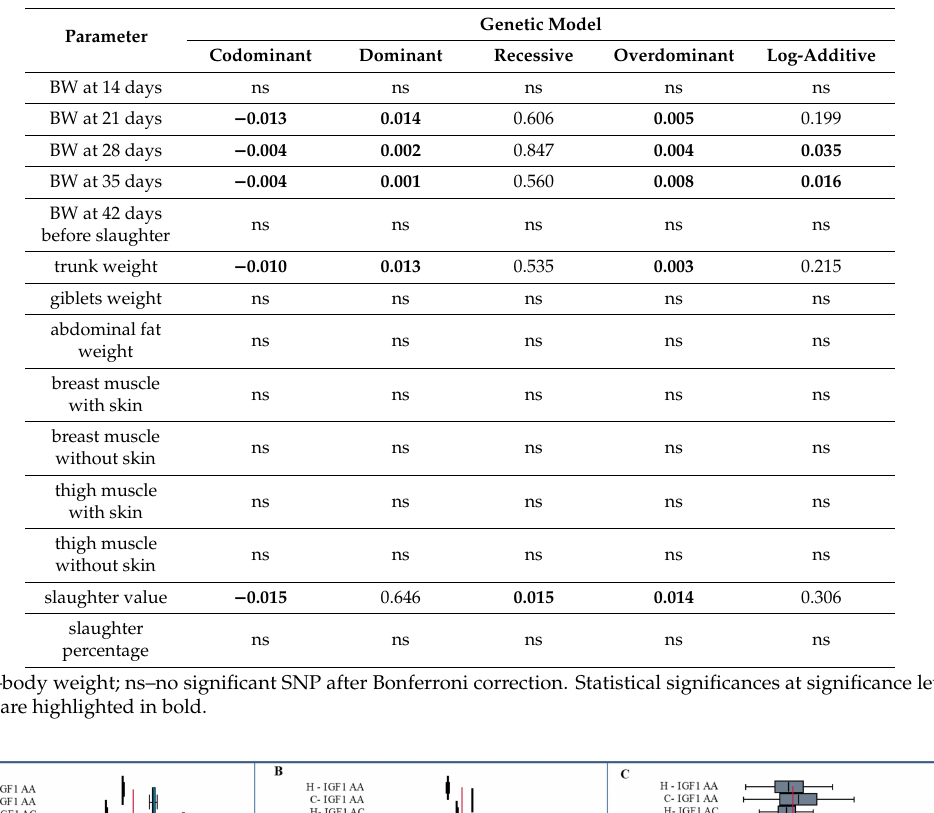
Table 8. Results of statistical analysis for testing association between TGF β 3 polymorphism and growth performance and carcass traits in the chicken population.